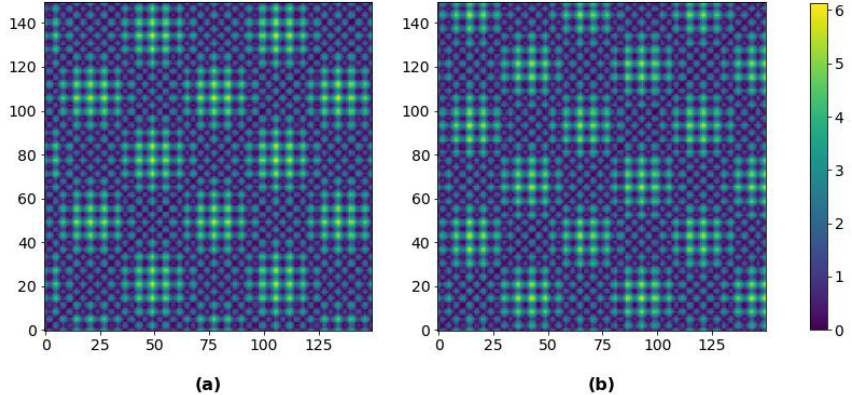
Figure 9. GRPs for CNN feature extraction through transfer learning: ( a ) NOC data (occurring before t = 1000); and ( b ) fault data (occurring after t = 1000 in Figure 8). The color scale defines the Euclidean distances represented by different RGB pixel values.